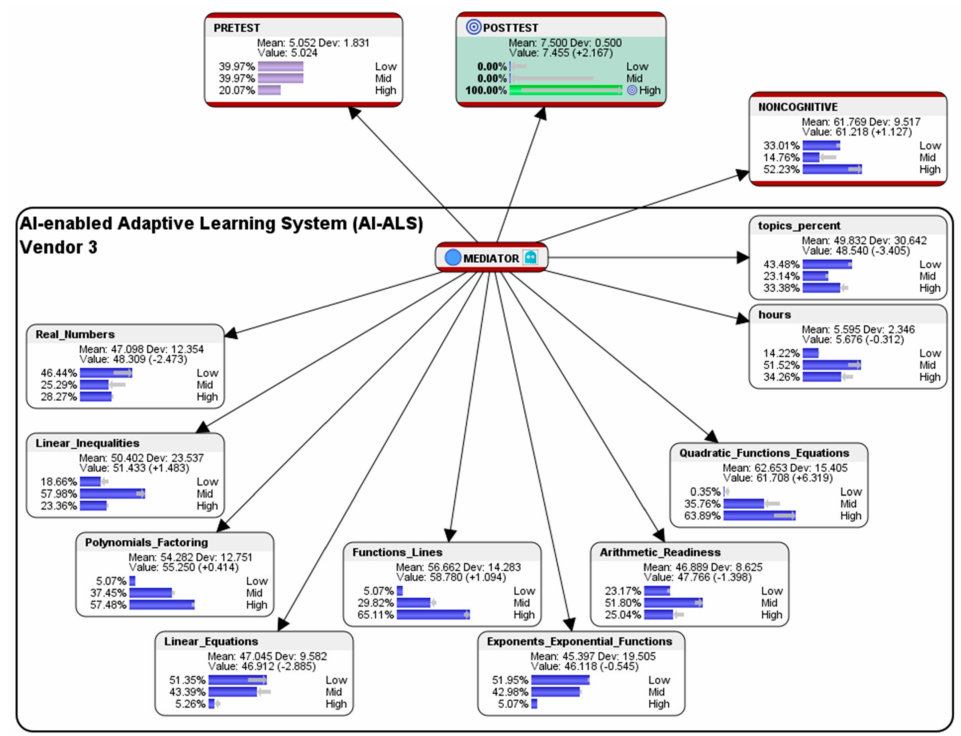
Figure 18. Simulation of counterfactual results for 100% of the students who had used Vendor 3 (cid:48) s AI-ALS to score at the high-level in the